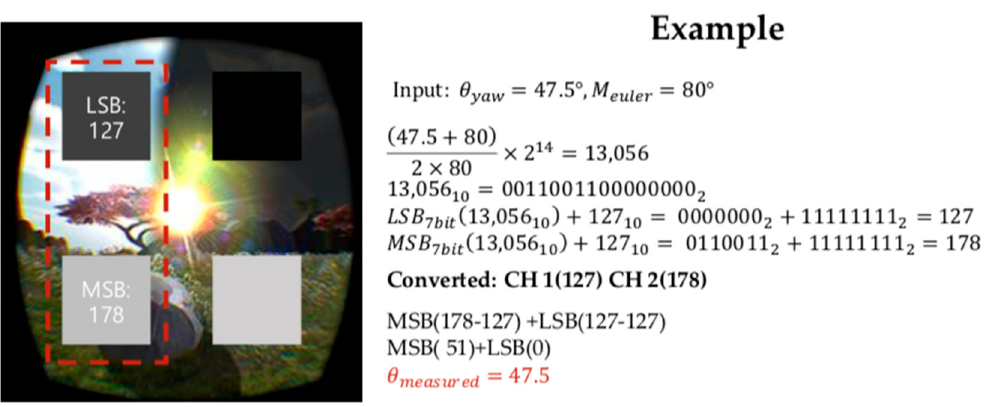
Figure 7. Example of the intensity level conversion and its inverse for measuring the current rotation angle.